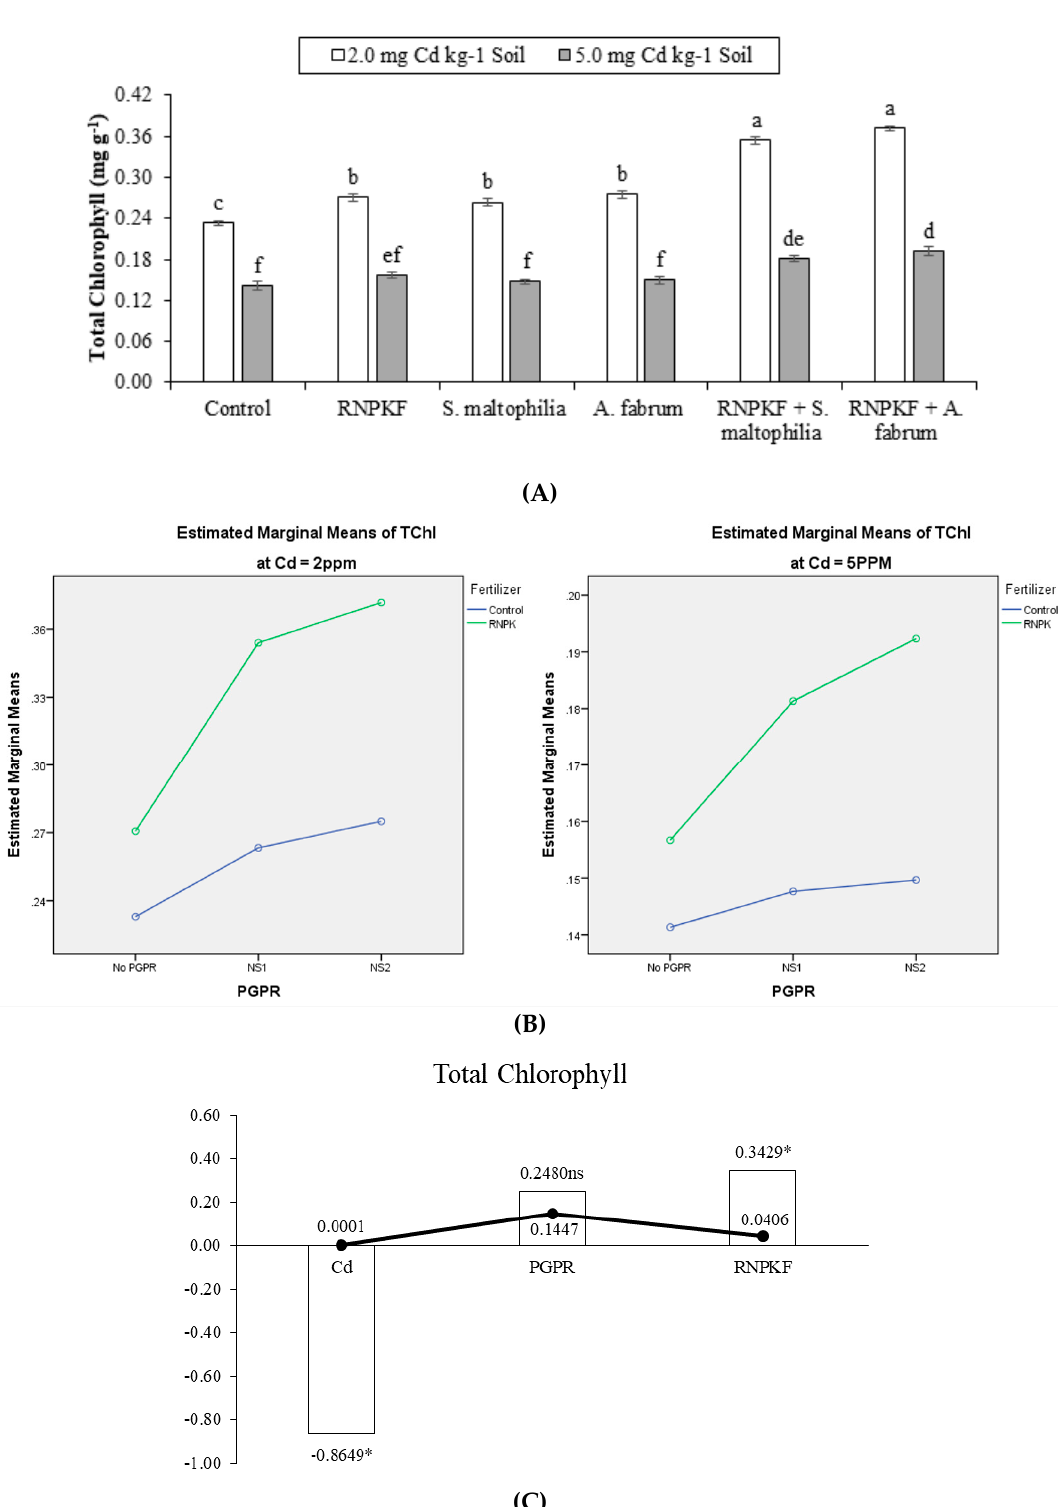
Figure 6. Effect of rhizobacteria with and without recommended NPK fertilizer on total chlorophyll (TChl) of bitter gourd under Cd ( A ). Interaction graph of PGPR (NS1 = S. maltophilia , NS2 = A. fabrum ), RNPKF and Cd levels for TChl (mg g − 1 ) ( B ). Pearson correlation of TChl with different levels of Cd, ACCD PGPR, and recommended NPK fertilizer where the y -axis represents the values of correlation (bars in the graph) and x -axis probability (lines in the graph) ( C ). * = p ≤ 0.05; ns = p > 0.05 non- significant.